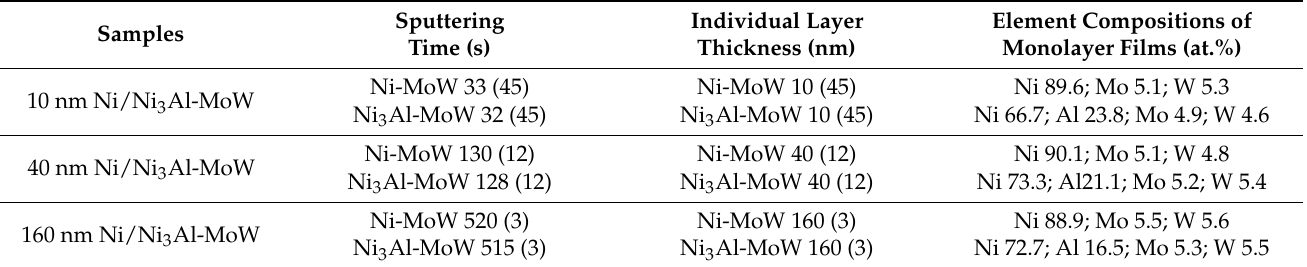
Table 1. Typical magnetron sputtering, structure, and composition parameters of